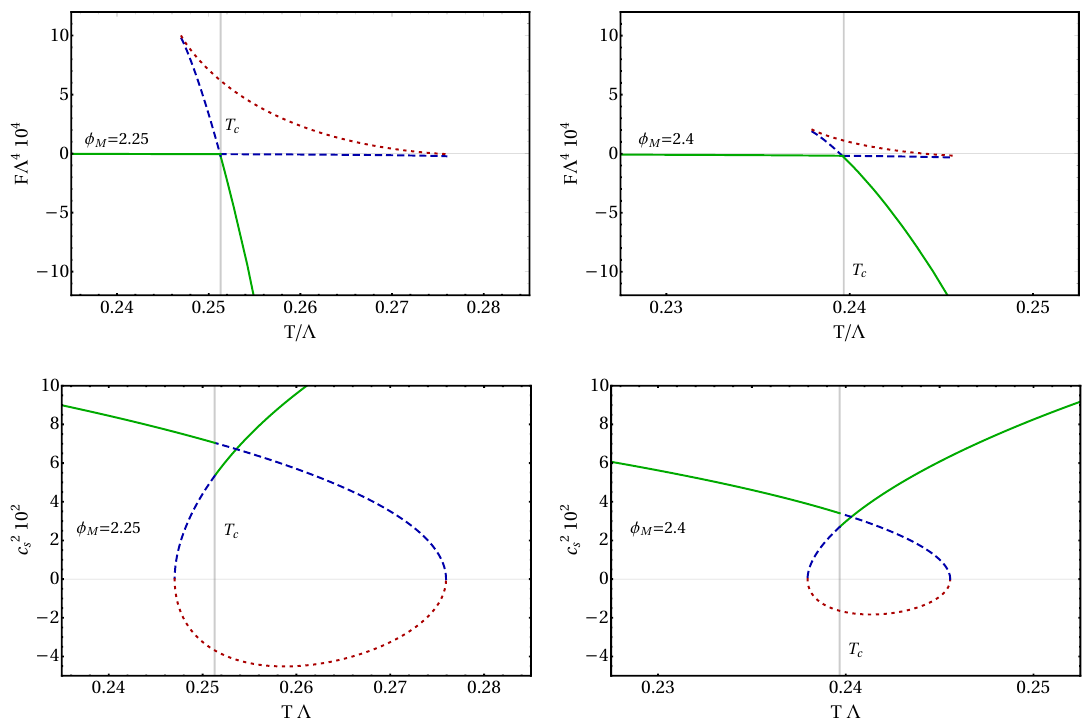
Figure 2 . The free energy F and the speed of sound squared c 2 with different first order phase transitions far from the critical point and closer to the critical point with varying criticality due to different φ M = { 2 . 25 , 2 . 4 } . Each phase is denoted by the same color scheme as in figure 1.